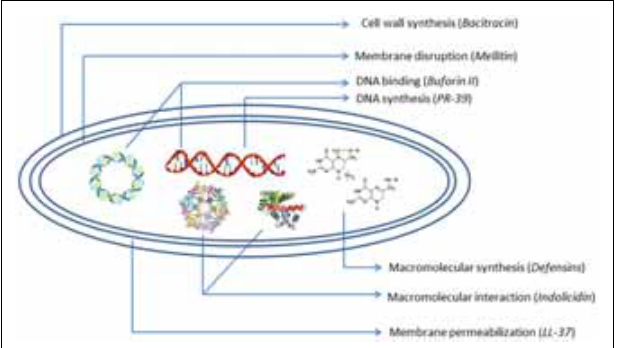
FIGURE 2 | Schematic diagram of antibacterial peptides with mechanism of